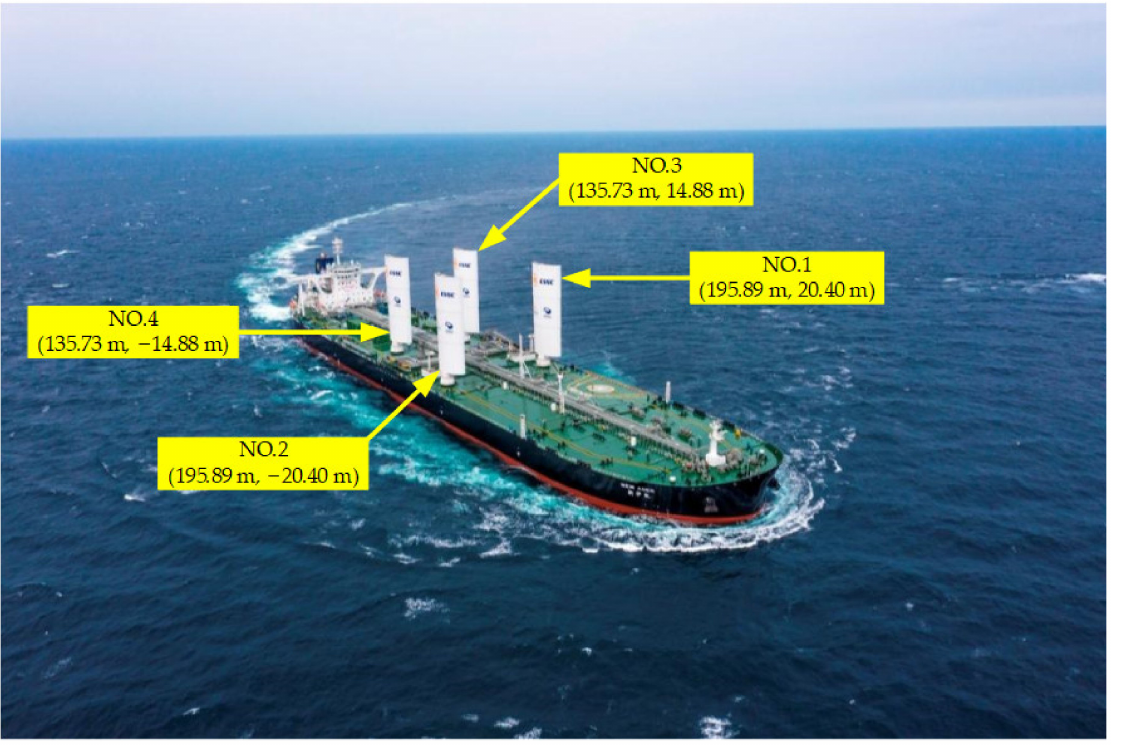
Figure 8. Target ship and wing sail positions.